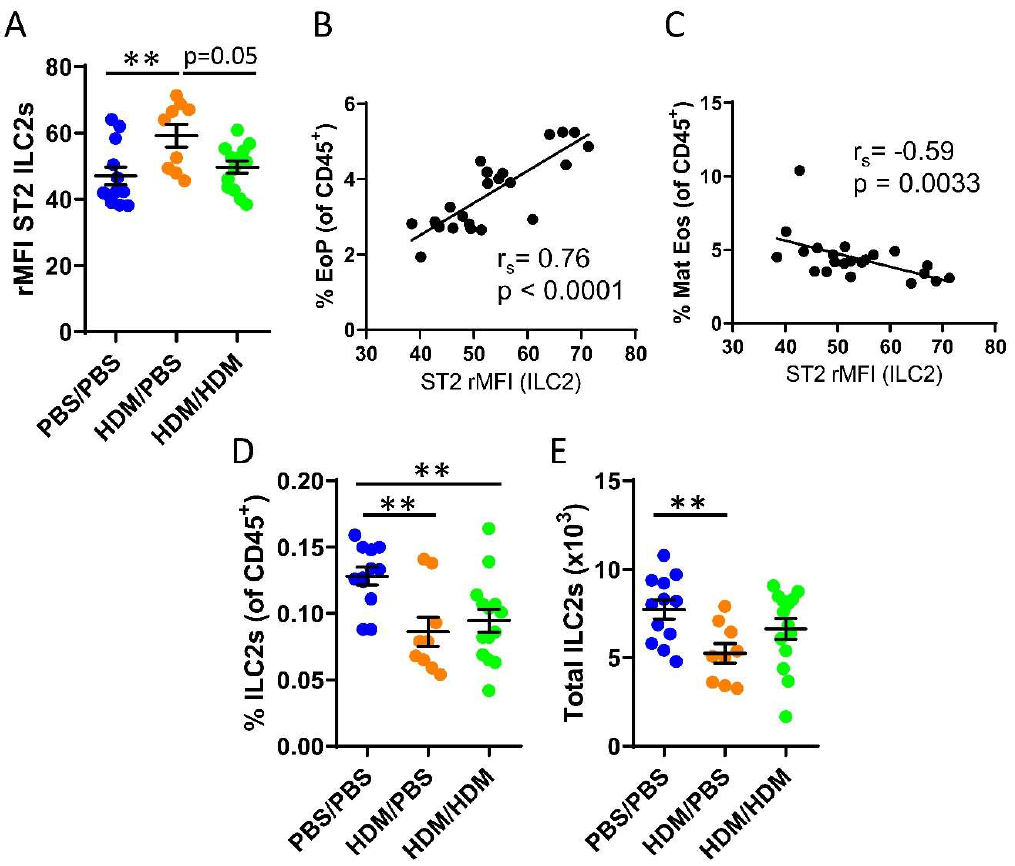
Figure 2. IL-33-responsive type 2 innate lymphoid cells (ILC2s) during eosinophilic inflammation